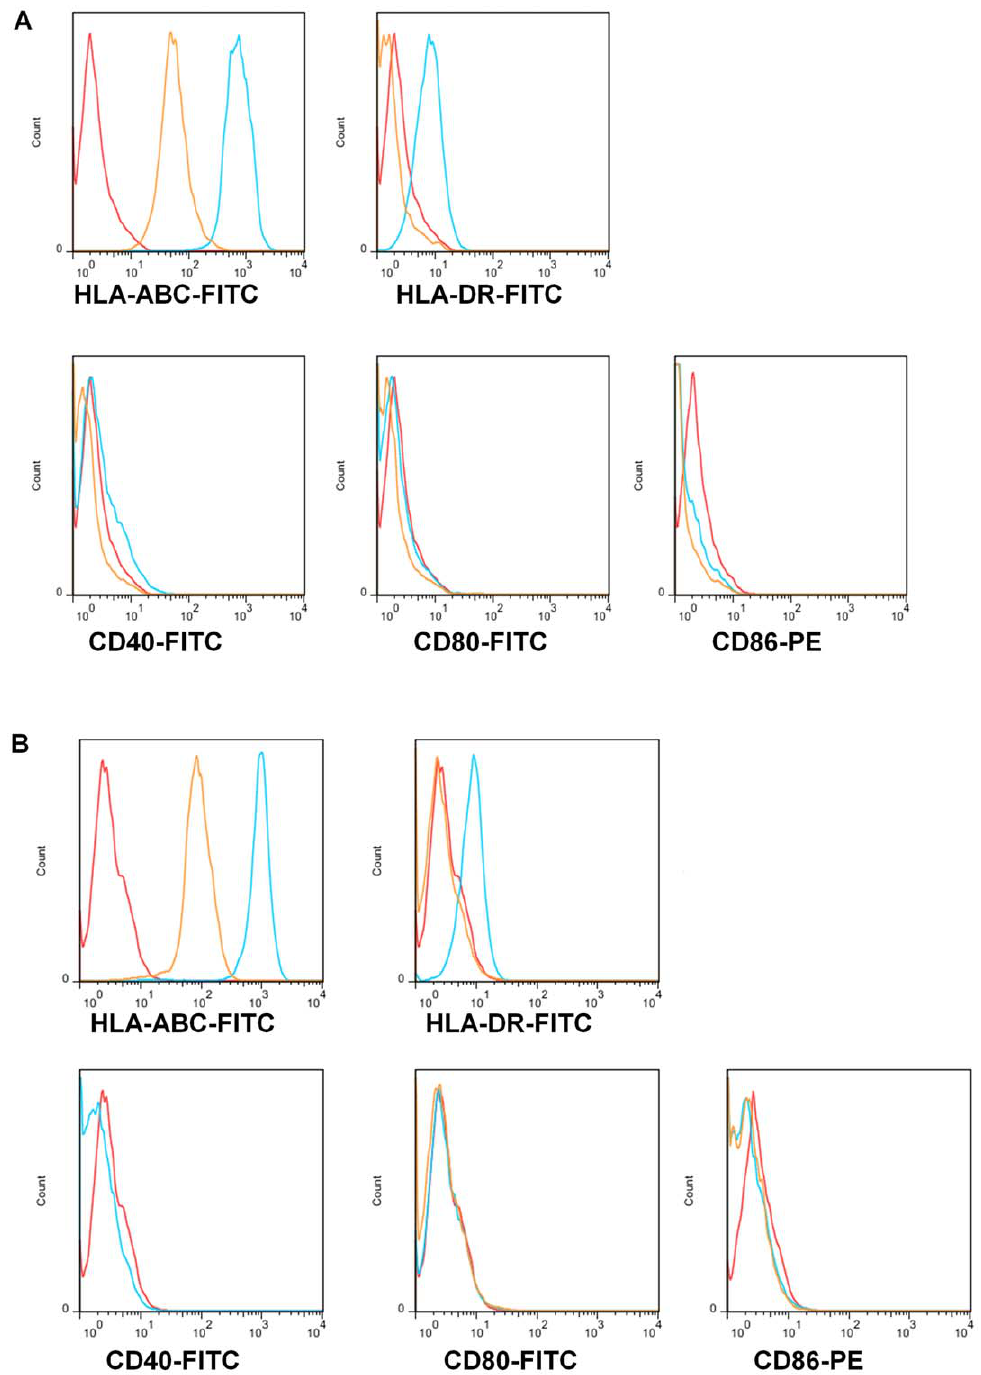
Figure 1. The effect of IFN- c on the immunophenotype of AFS cells and BM-MSCs. BM-MSCs (A) or AFS cells (B) were cultured under growth conditions with (blue) and without (yellow) addition of IFN- c stimulation for 24 hours. The cells were incubated with fluorescently labeled antibodies against the the major histocompatibility complex molecules MHC-I and MHC-II as well as the costimulatory molecules CD40, CD80 and CD86. The red line shows appropriate isotype controls. A. BM-MSCs under growth conditions express high levels of MHC-I and no MHC-II, CD40, CD80 or CD86. Upon IFN- c stimulation MSCs upregulate MHC-I and MHC-II while CD40, CD80 and CD86 remain unchanged. B. AFS cells show similar expression patterns to MSCs with high levels of MHC-I and no MHC-II, CD40, CD80 or CD86. AFS cells also upregulate MHC-I and MHC-II in response to IFN- c stimulation. Before stimulation they express high levels of MHC-I but low levels of MHC-II, CD40, CD80 and CD86. After IFN- c stimulation the levels of MHC-I and MHC-II expression increase but CD80 and CD86 expression remains unchanged.